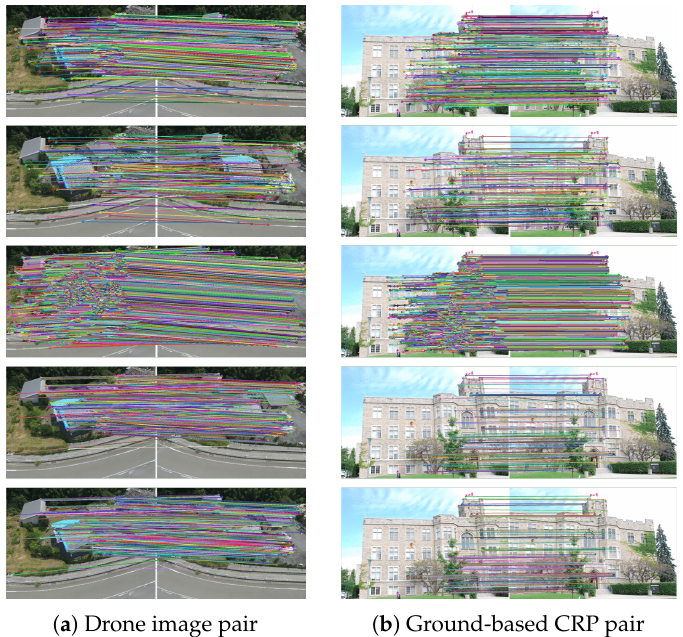
Figure 8. Image matching by using CRPs (from top to bottom: EABRISK, SC-EABRISK, SC-EABRISK with ATBB, BEBLID, LATCH).